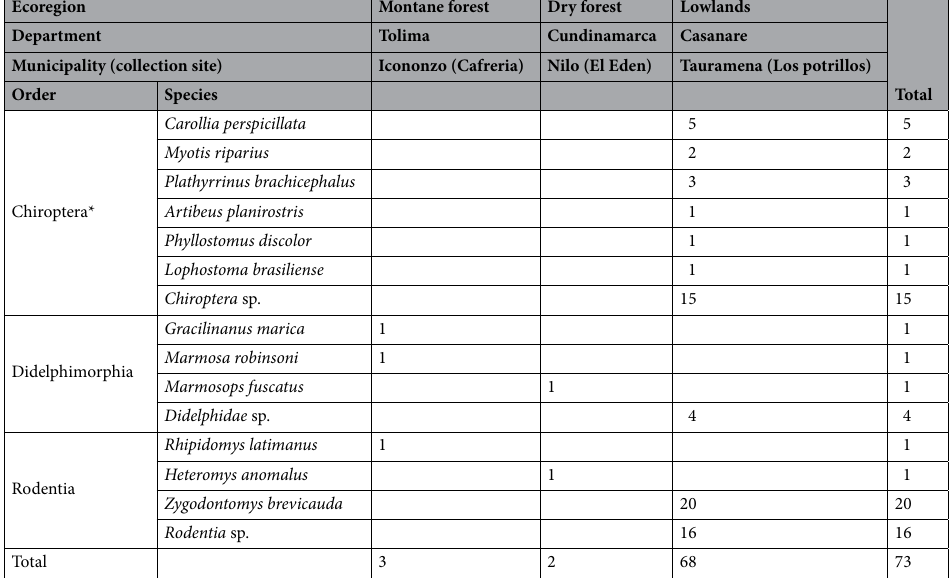
Table 2. Mammal species and number of individuals collected in each locality. *Sampled only in